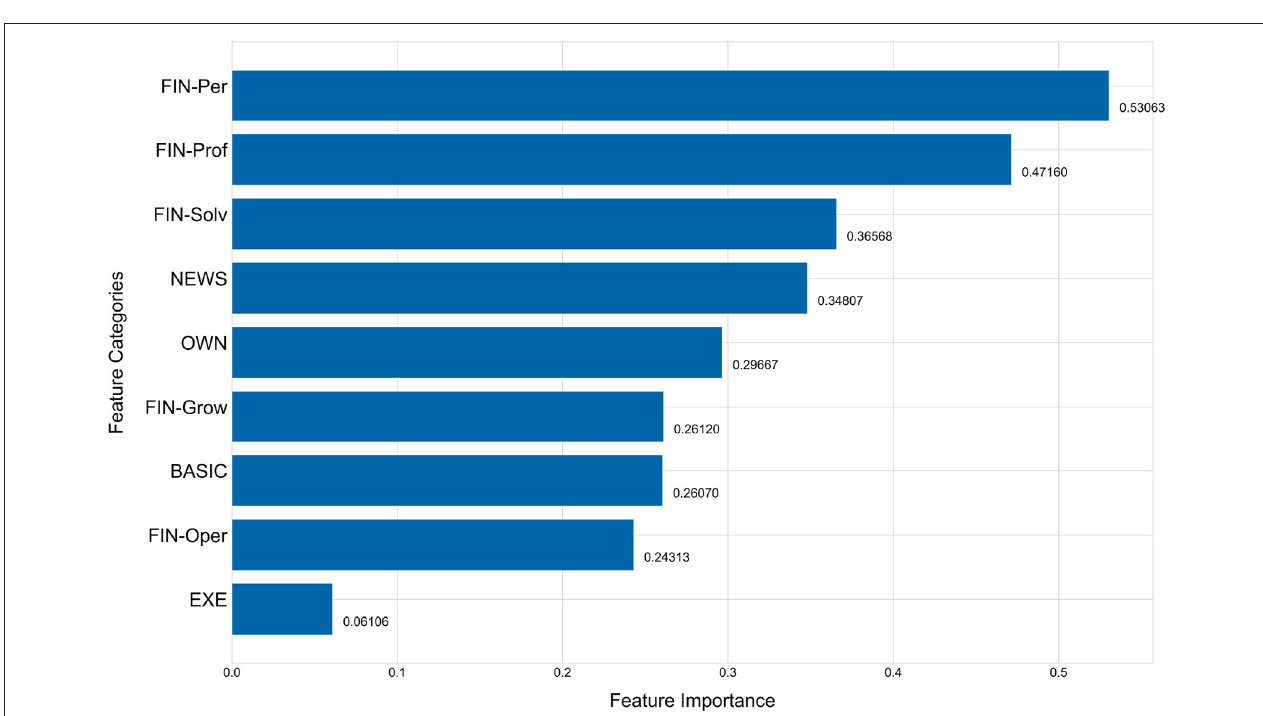
FIGURE 6 | Feature importance of every feature category-A breakdown of the FIN